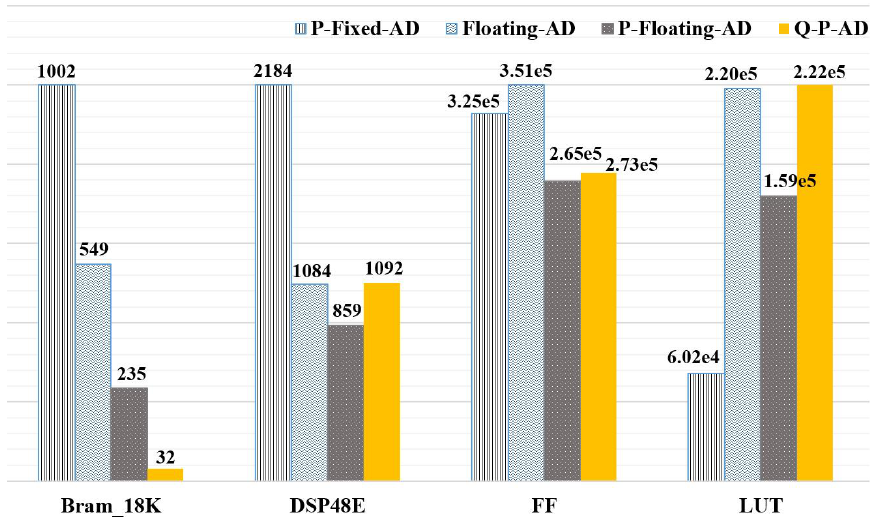
Figure 23. The computational resources consumption by different detectors. To make those detectors reach its maximum parallel for high detection speed, the detectors are designed as high as possible until one of the resources consumption reaches the limitation of the field-programmable gate arrays (FPGA) chip for each